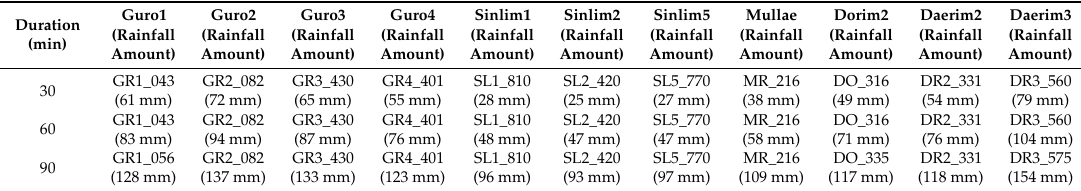
Table 6. The results of the first flooding nodes for the operation of drainage facilities in each drainage area.